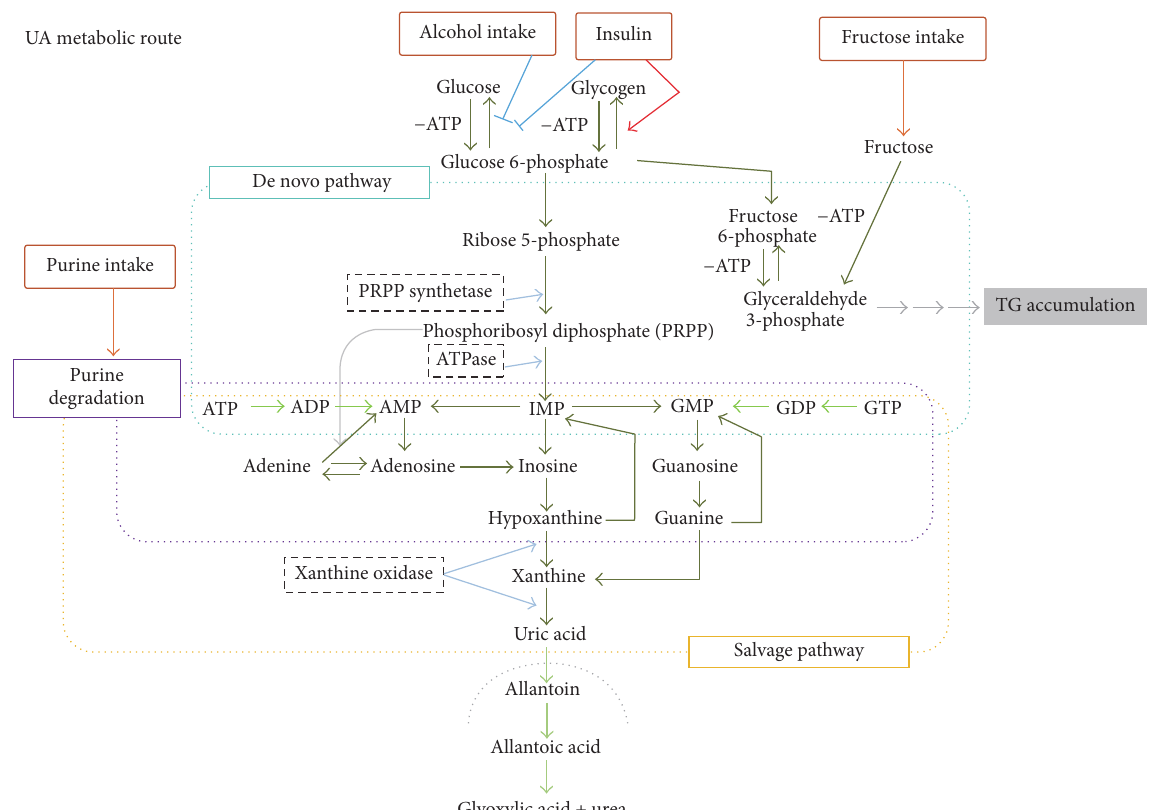
Figure 1: Metabolic pathways involving